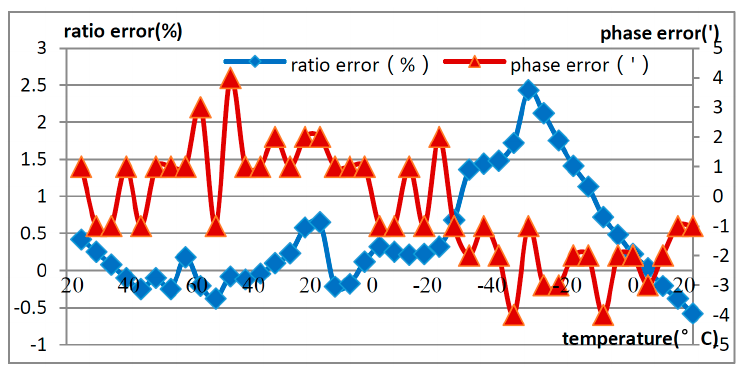
Figure 9. Temperature curve with time.